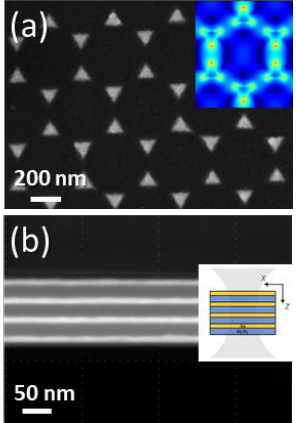
Fig. 1. (a) SEM image in plane-view of an Ag honeycomb nanoprism array (HNPA). Inset: local-field enhancement computed at the dipolar surface plasmon resonance of the HNPA. (b) SEM image in cross-section of an Au/Al 2 O 3 multilayer hyperbolic metamaterial (MHM). Inset: sketch of the